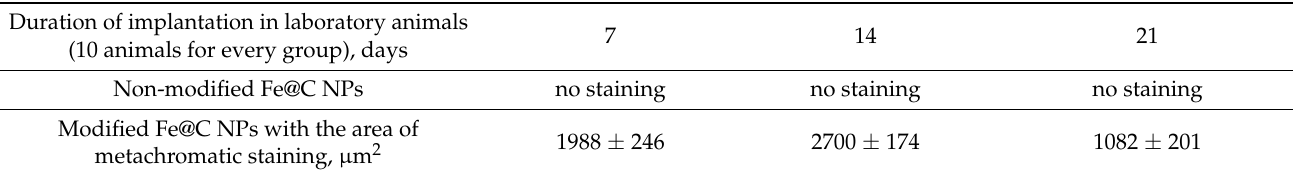
Table 1. Quantitative estimation of metachromatic staining in the structure of atherosclerotic plaques, depending on the time of their contact with chemically modified and non-modified NPs in the subcutaneous tissue of laboratory animals. Duration of implantation in laboratory animals (10 animals for every group), days